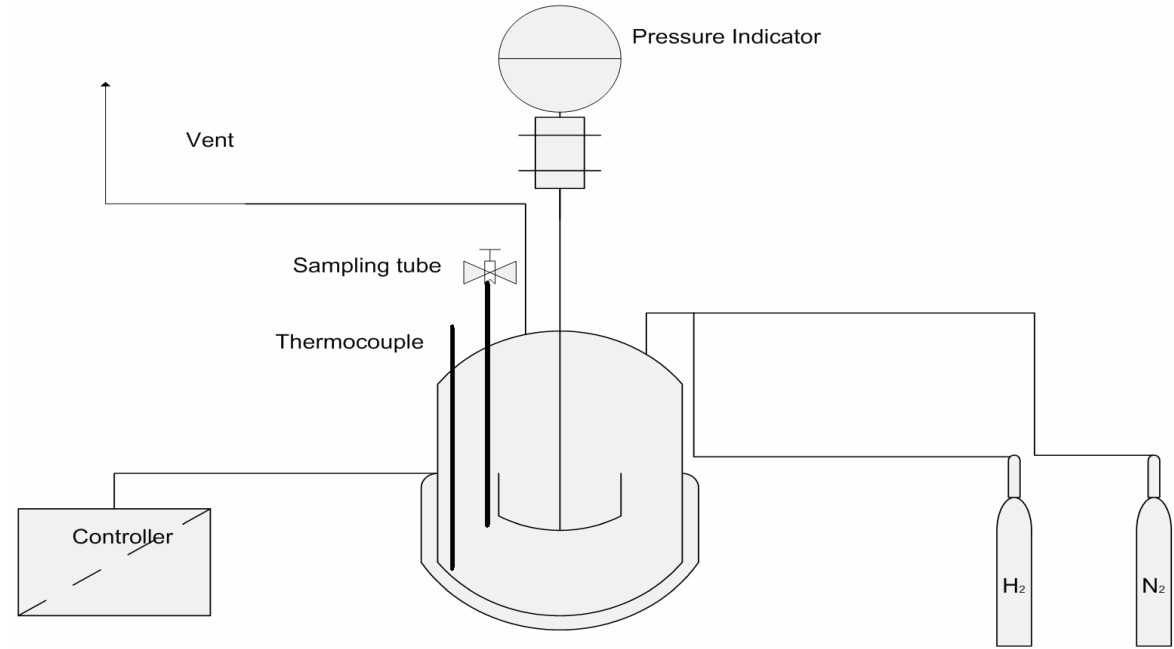
Scheme 2. Schematic representation of the experimental